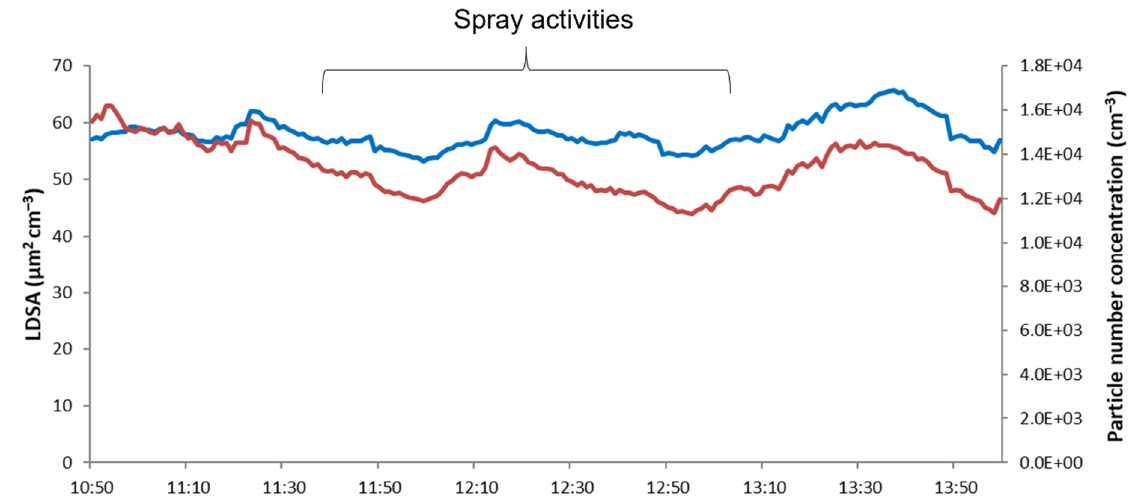
Figure 11. Temporal trend of LDSA (blue line) and particle number concentrations (red line) measured by DiSCmini.